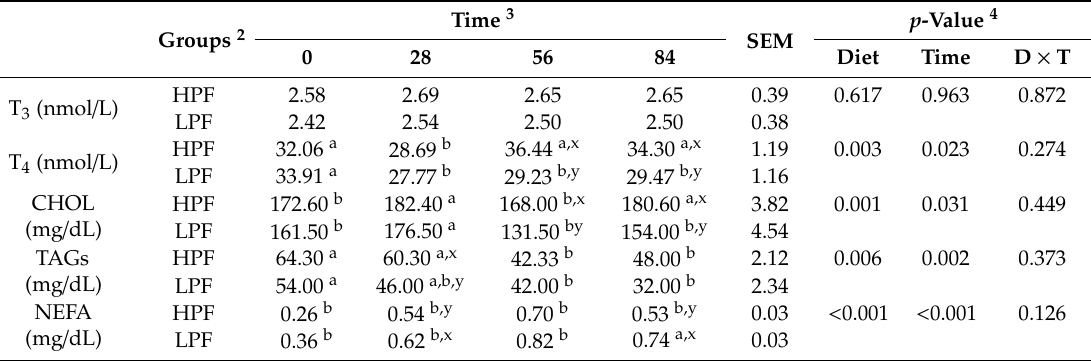
Table 4. Profile of serum hormonal and lipid panel concentrations during the trial 1